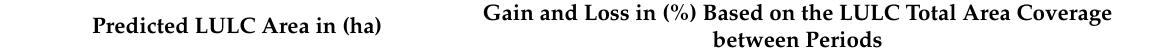
Table 4. Predicted LULC area (ha) and the gain and loss in (%) based on the LULC total area coverage across the study periods.